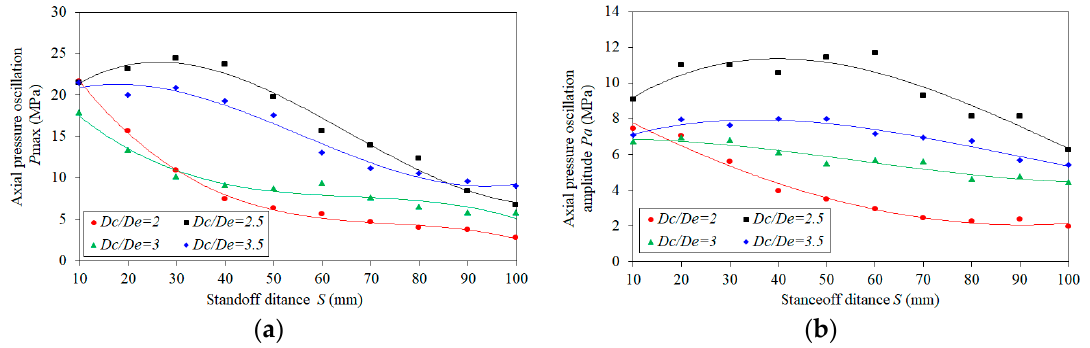
Figure 5. The axial pressure oscillation ( a ) peak and ( b ) amplitude against the standoff at an inlet pressure of 20 MPa.